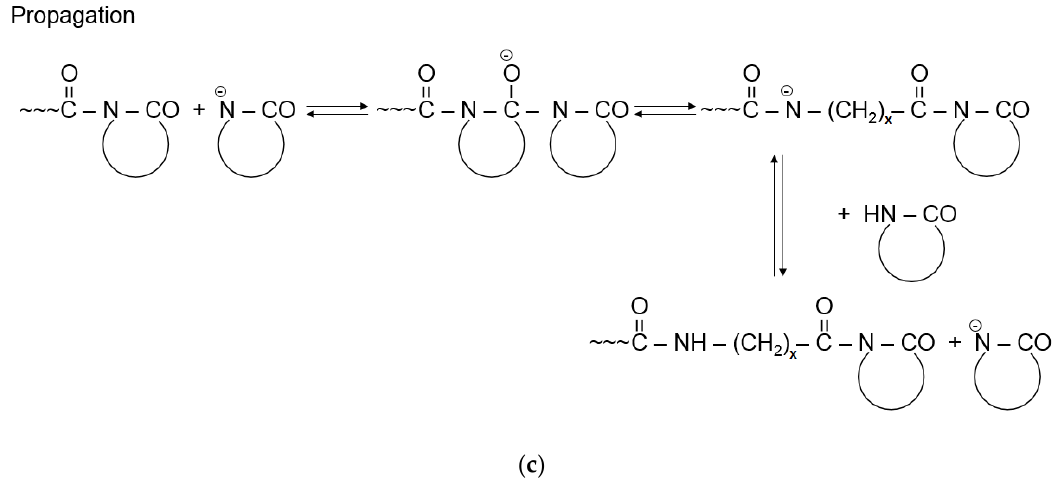
Figure 4. Initiation ( a,b ) and propagation ( c ) of the AROP of ε‐ CL (Note: x = 5), reprinted from [1] under open access